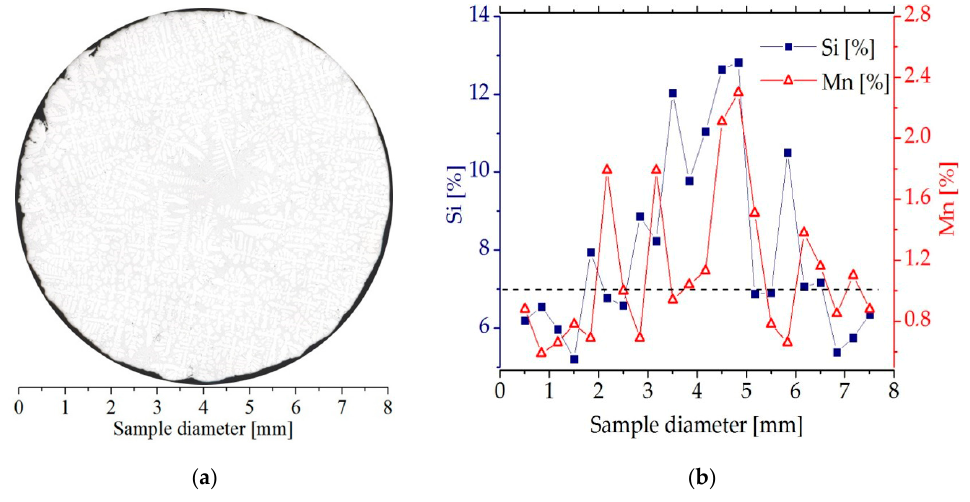
Figure 3. ( a ) a microstructure on the cross section of the Al-7 wt % Si-1.0 wt % Mn specimen solidified under influence of a rotating magnetic field ( G = 3 K/mm, v = 0.04 mm/s, B = 6 mT); ( b ) silicon and manganese concentration profile on the Al-7 wt % Si-1.0 wt % Mn specimen ( G = 3 K/mm, v = 0.04 mm/s, B = 6 mT).